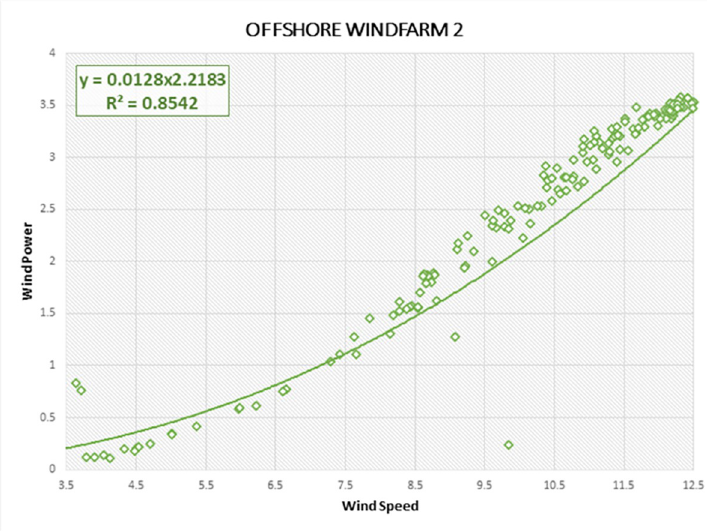
Fig 13. R-Squared correlation and best curve fitting on wind power and wind speed observations of Offshore Windfarm 2 dataset. https://doi.org/10.1371/journal.pone.0256381.g013 within each curve, whereas the horizontal line indicates the attributes of the wind data as observed values. The green dots comprise the specification and the dynamics of the wind data as well as the linear regression curve depicts a model strength dependent on R-Squared. We also derived R-Squared curves to determine the performance of the proposed DAE-CNN-LSTM model. The closer wind points along linear regression axis shows the better variance and accuracy of the model. All three Offshore Windfarm datasets have obtained an R-Squared correlation of 91.77%, 85.42%, 90.77% respectively. Figs 12–14 illustrate that the data points in Offshore Windfarm 1 are more proportionate to the linear axis compared to